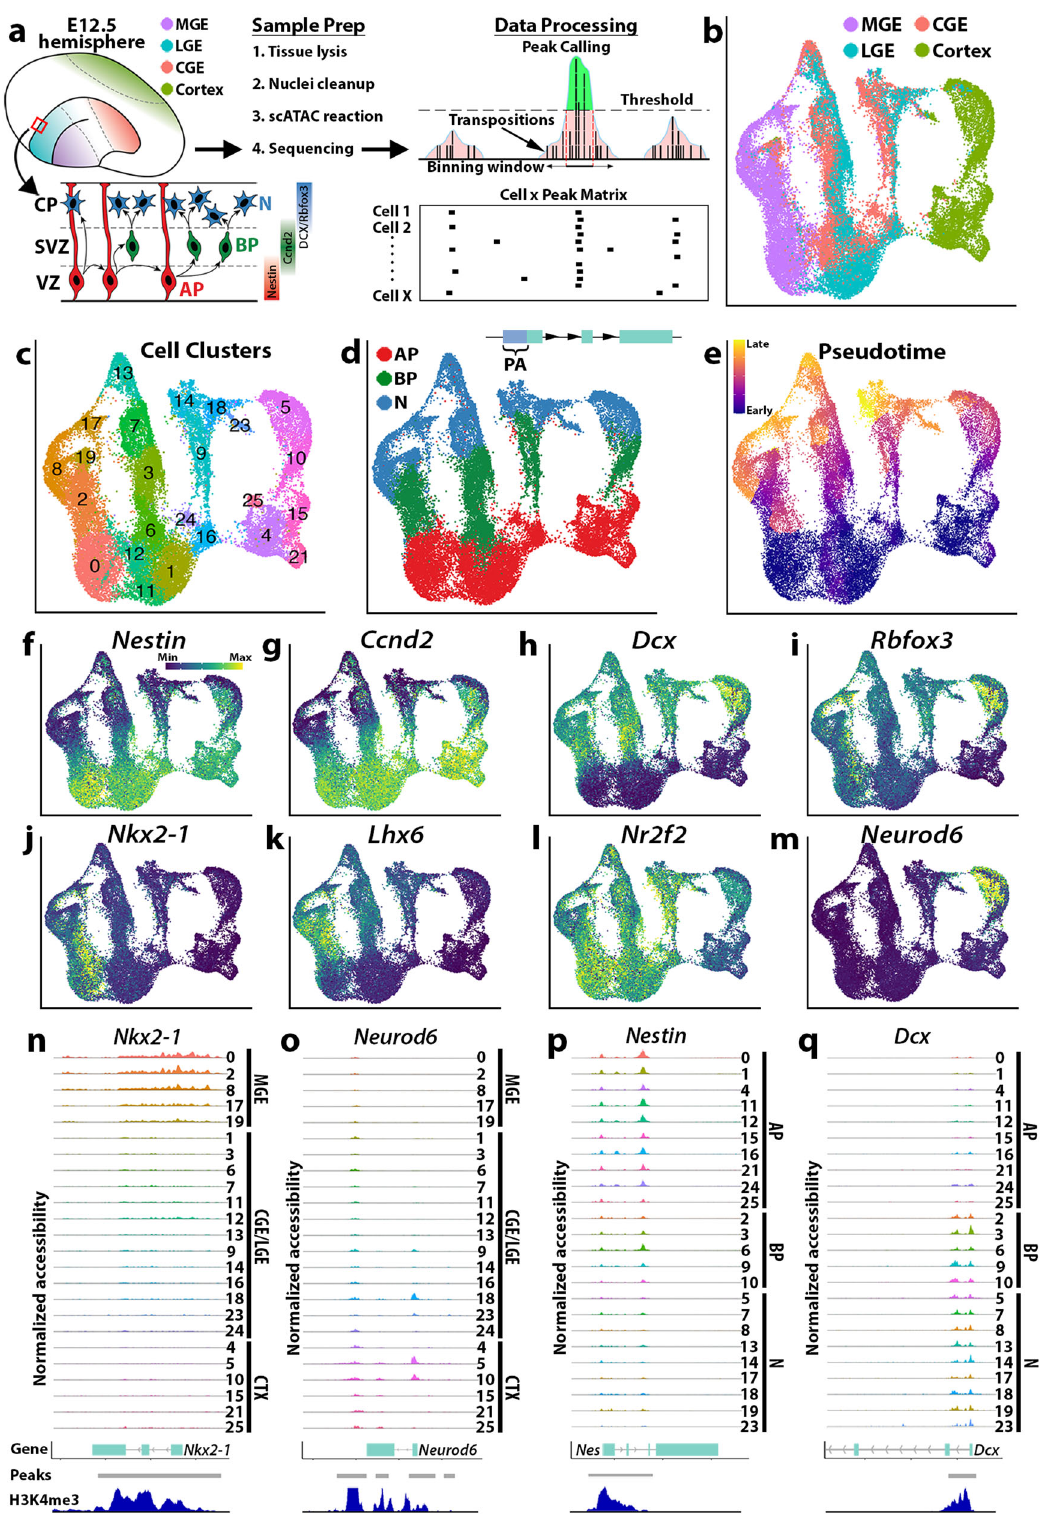
Fig. 1 Chromatin accessibility in the mouse embryonic forebrain is cell type and state-speci fi c. a Schematic of snATAC-Seq work fl ow and neurogenic cell types: apical progenitors (APs), basal progenitors (BPs), and posmitotic neurons (Ns). b – e UMAP visualization of single nuclei clustered by brain region ( b ), SLM ( c ), neurogenic cell type ( d ), and pseudotime ( e ). In d , promoter accessibility (PA) representing reads mapping within 2 kb upstream of TSSs. f – m PA scores for genes enriched in speci fi c neurogenic cell types ( f – i ) or distinct brain regions ( j – m ). n – q Aggregated reads per SLM cluster. Nkx2-1 (MGE), Neurod6 (cortex), Nes (APs), and Dcx (BPs/Ns), arranged by either brain region ( n , o ) or neurogenic cell type ( p , q ). The y-axis range for chromatin accessibility tracks are normalized to the maximum reads per gene. Peaks: differentially accessible peak coordinates, H3K4me3: H3K4me3 signal from E12.5 forebrain ENCODE ChIP-Seq data.